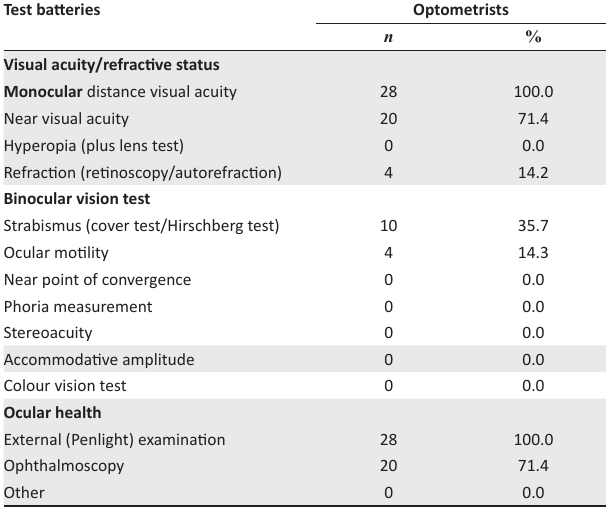
TABLE 3: Number of optometrists that performed specific vision tests in paediatric vision screenings.